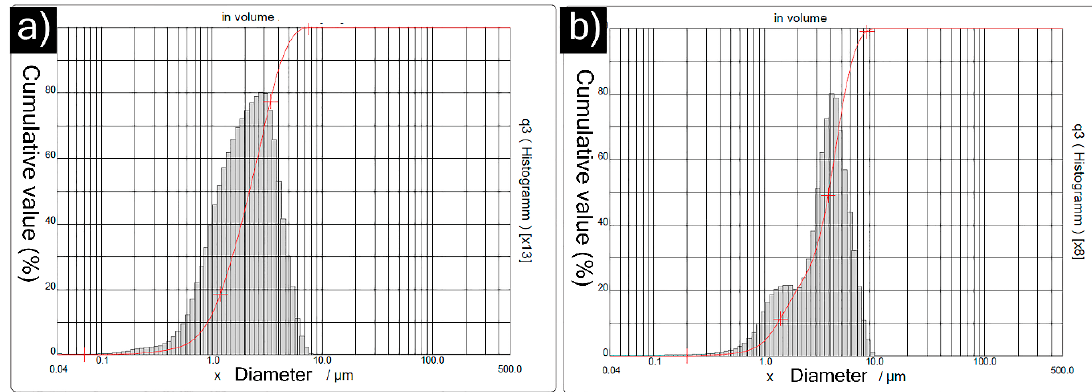
Figure 2. Particle size distribution of ( a ) TiC powder feedstock ( b ) Cr 3 C 2 powder feedstock.